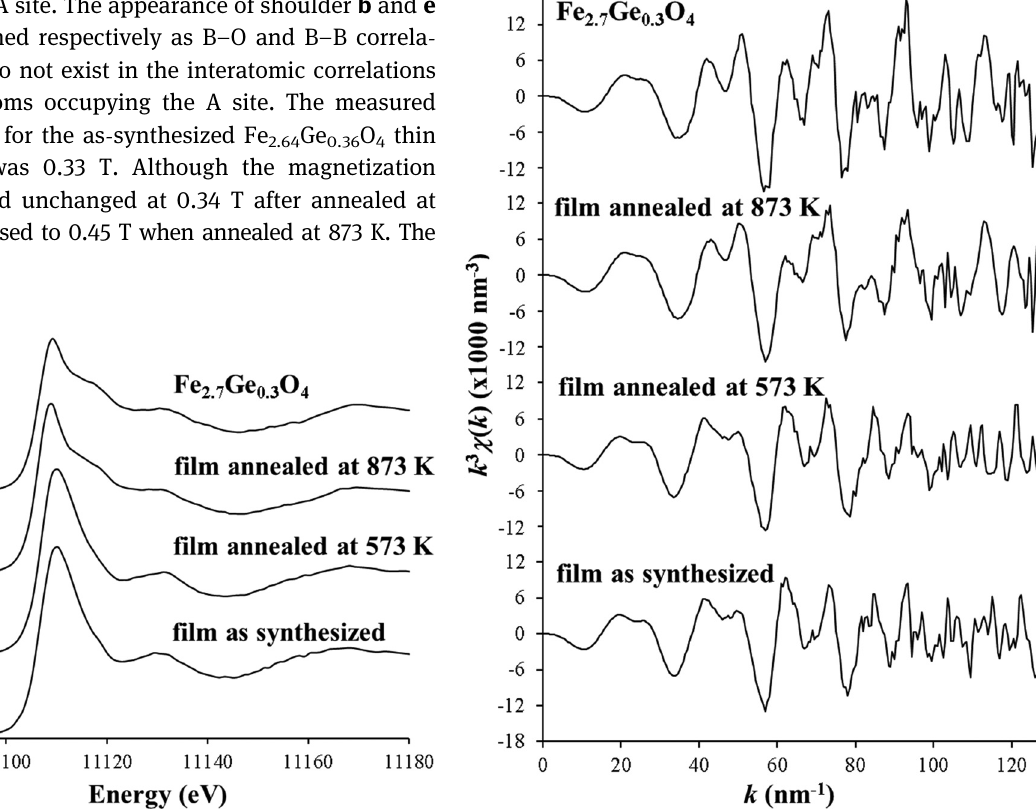
Figure 2: Normalized XANES spectra measured at Ge K absorption edge for as - synthesized and annealed Fe 2.64 Ge 0.36 O 4 films with reference Fe 2.7 Ge 0.3 O 4 .